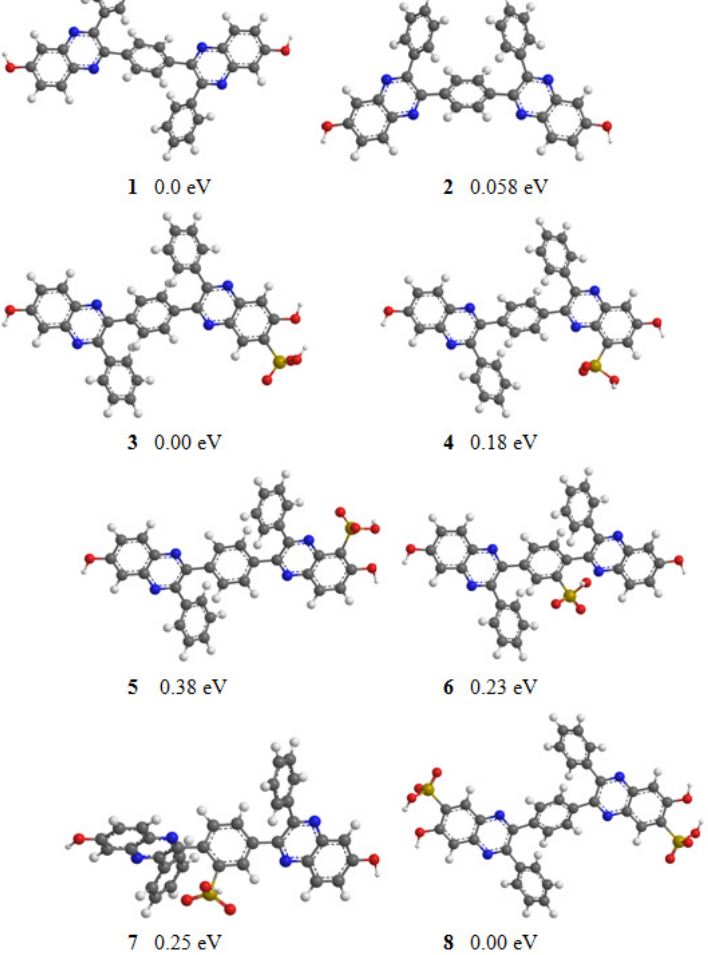
Figure 10. Various variants of attachment of a sulfogroup to a unit of phenylquinoxaline oligomer and their relative stability.